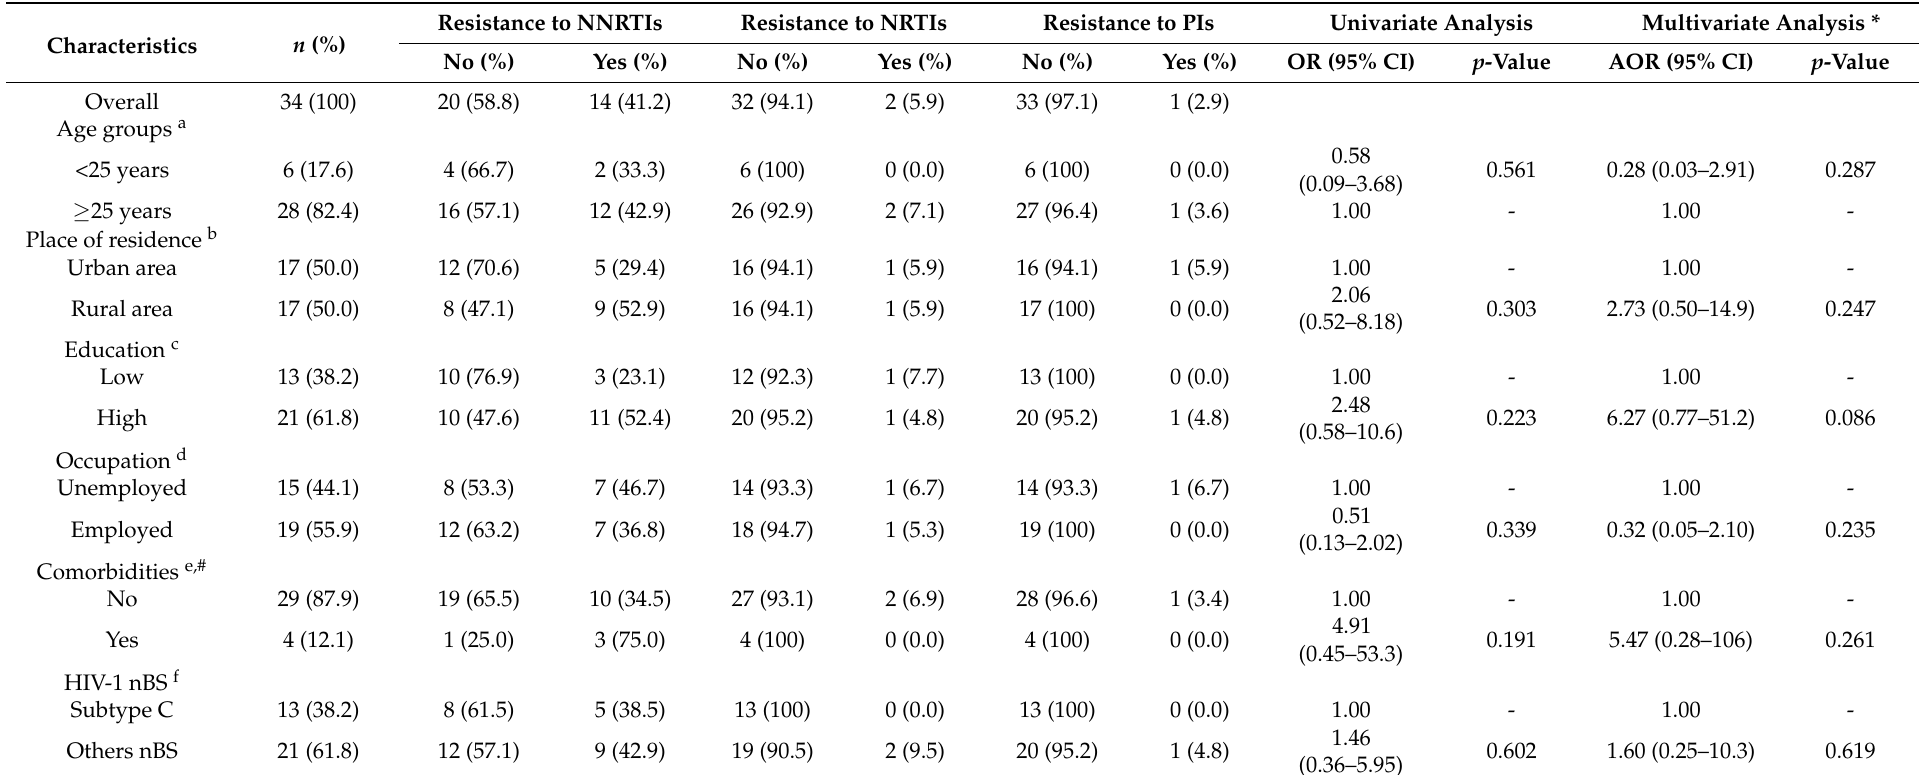
Table 2. Putative factors related to drug resistance among HIV-positive pregnant women in Luanda, Angola,